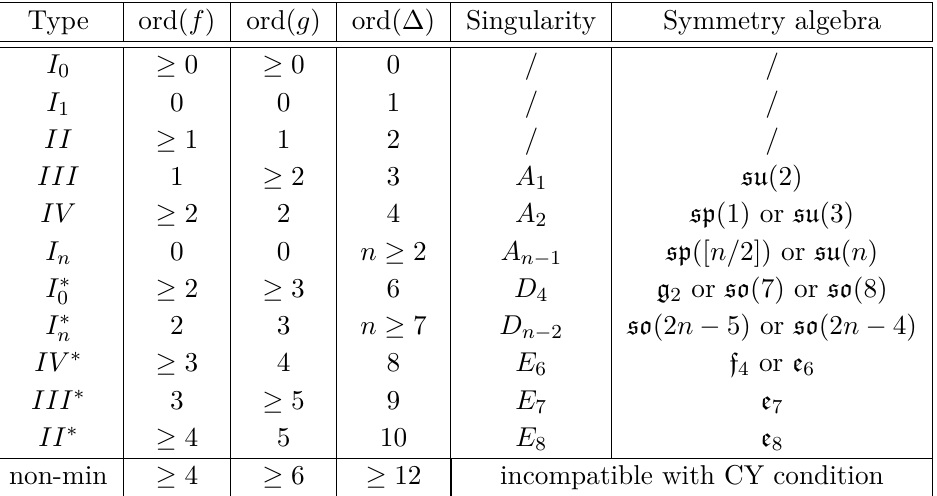
Table 1 . Kodaira classification of singular elliptic fibers, mapping vanishing orders to non-abelian gauge groups up to